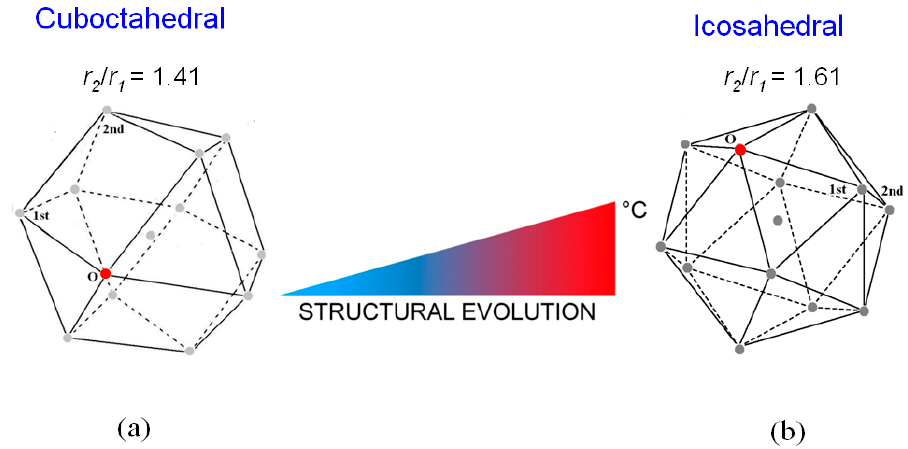
Figure 4. The structure of the liquid LBE alloy passes from the cuboctahedral configuration ( a ) to the icosahedral one ( b ) as temperature increases from 125 °C to 720 °C. The positions of 1st and 2nd nearest neighbors of a given atom in the position O are shown.